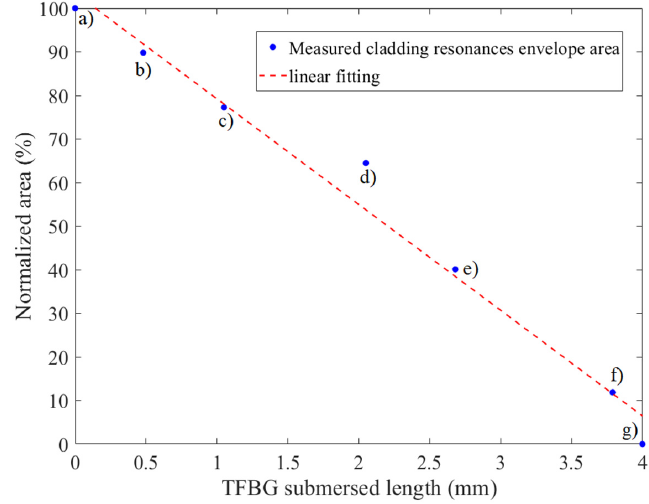
Figure 18. Trend of normalized cladding modes area versus the TFBG submerged length.